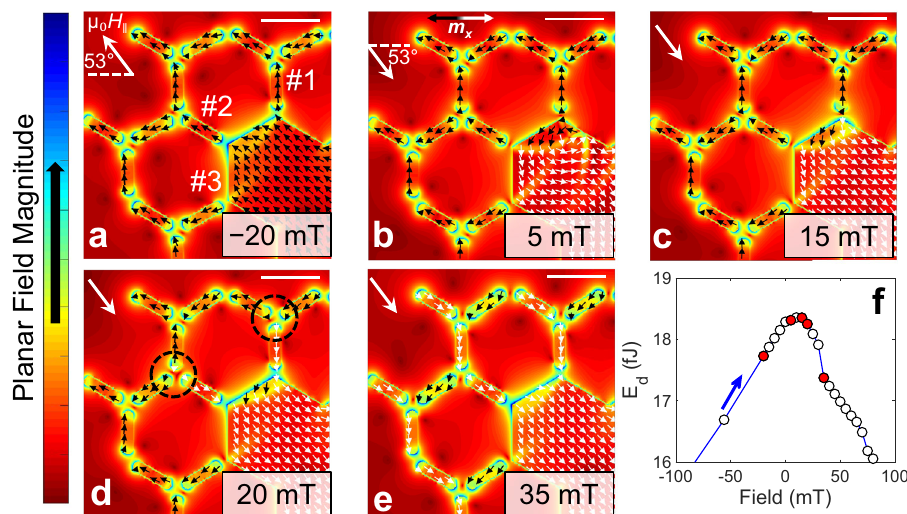
Fig. 3 Micromagnetic modeling of monopole injection. a – e 2D planar fi eld magnitude colormaps of the modeled lattice (top-left corner of the lattice is displayed for direct comparison with Fig. 2) at in-plane fi eld ( µ 0 H || ) iterations: − 20 mT; 5 mT; 15 mT; 20 mT; and 35 mT, respectively, along the indicated direction (top-left corner). Arrows represent the discretized magnetization vector colored to represent its alignment with respect to x -axis (as shown in b, top-right). Scale-bars represent 500 nm. f Plot of the demagnetization energy ( E d ) as a function of µ 0 H || ; blue arrow shows the sweep-direction and red circles represent the energies of the fi eld-maps in a – e